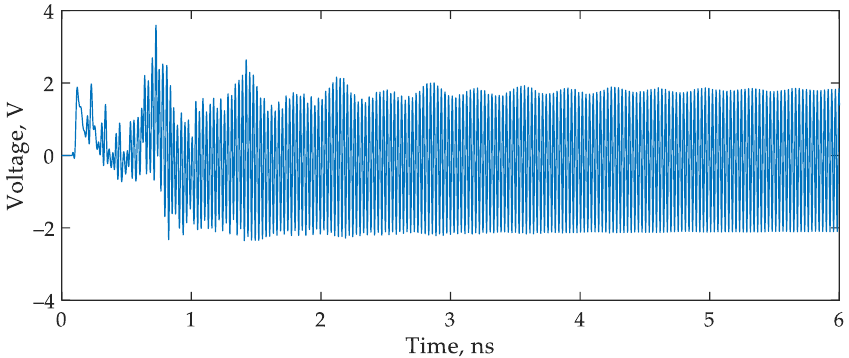
Figure 12. The waveform of the microwave signal at the MZM input.